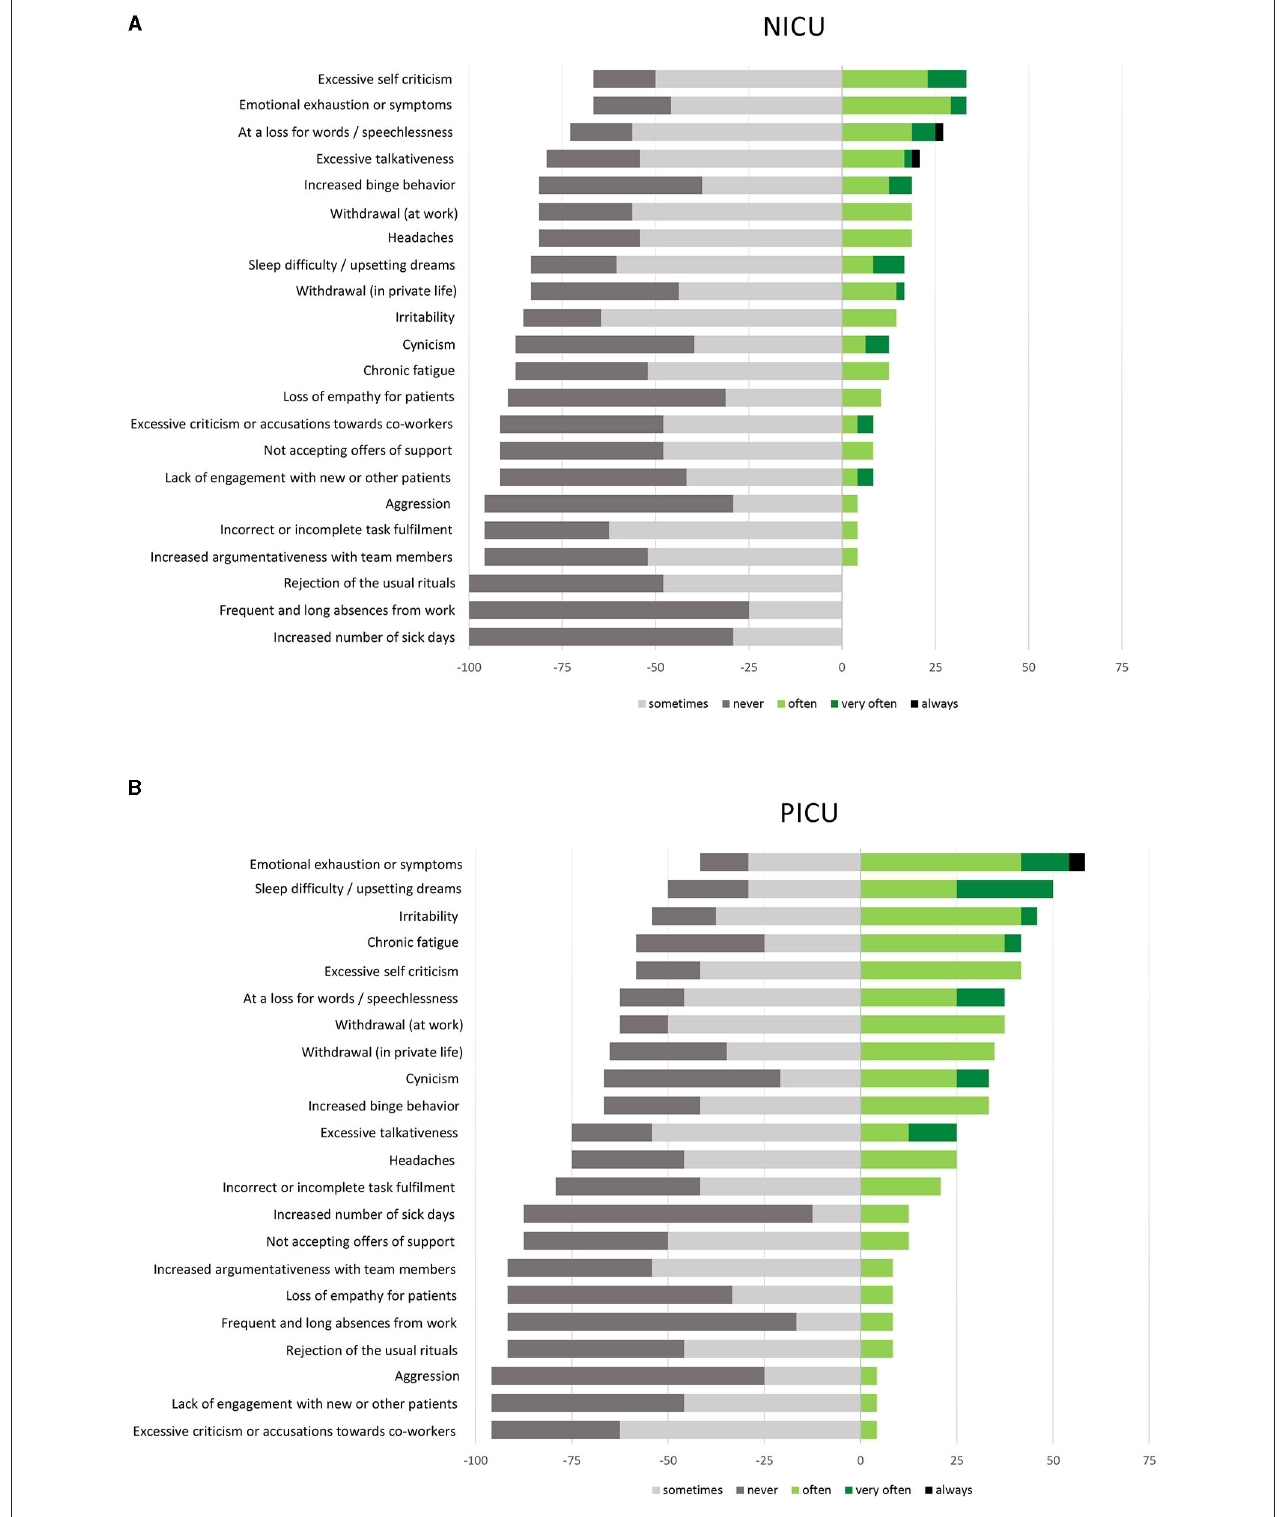
FIGURE 2 | Most frequent distress-related reactions or symptoms as self reported by (A) NICU staff and by (B) PICU staff (%). All questions to be rated by using a five-point Likert Scale.